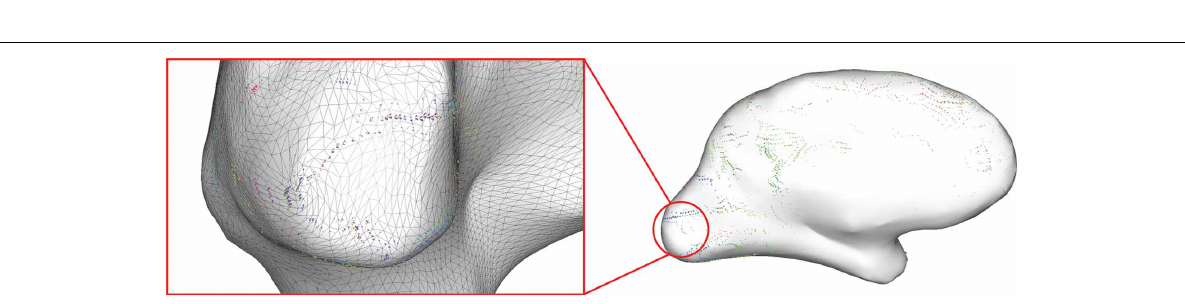
FIGURE 6 | Difference glyphs show the boundaries of the primary visual cortex (Left). The triangle mesh is overlaid to illustrate the placement of the difference glyphs in the middle of each triangle edge in order to show the difference in connectivity profile between two adjacent mesh nodes.